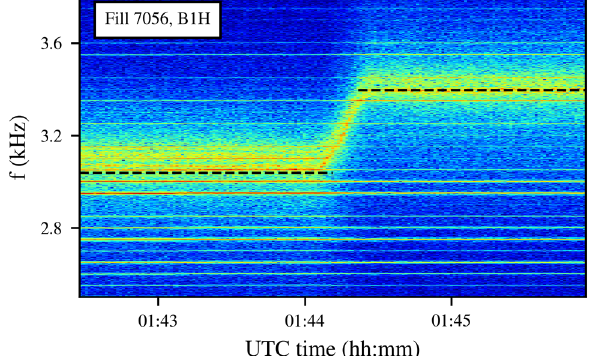
FIG. 9. The average phase advance from Q7 to Q9 for the harmonics in the low (blue) and high (orange) frequency cluster. The error bars represent one standard deviation and the gray dashed line illustrates the betatron phase advance (110 degrees).